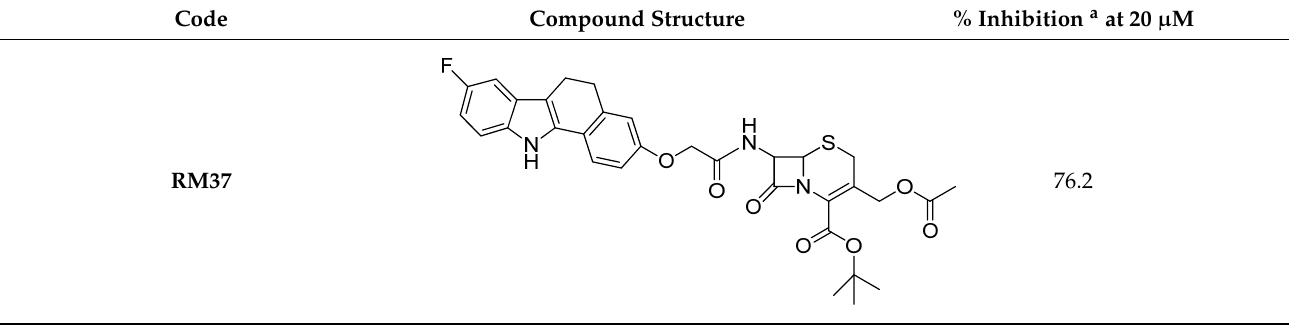
Table 1. Structures, in-house database codes, and MDM2 inhibitory activity of compounds selected from VS. a Evaluated by in vitro p53-p/HDM2 binding assay, as described in Costa et al., 2013 [25].